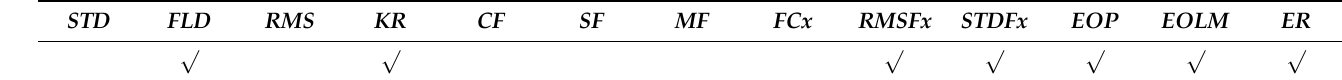
Table 5. Useful features of surge velocity